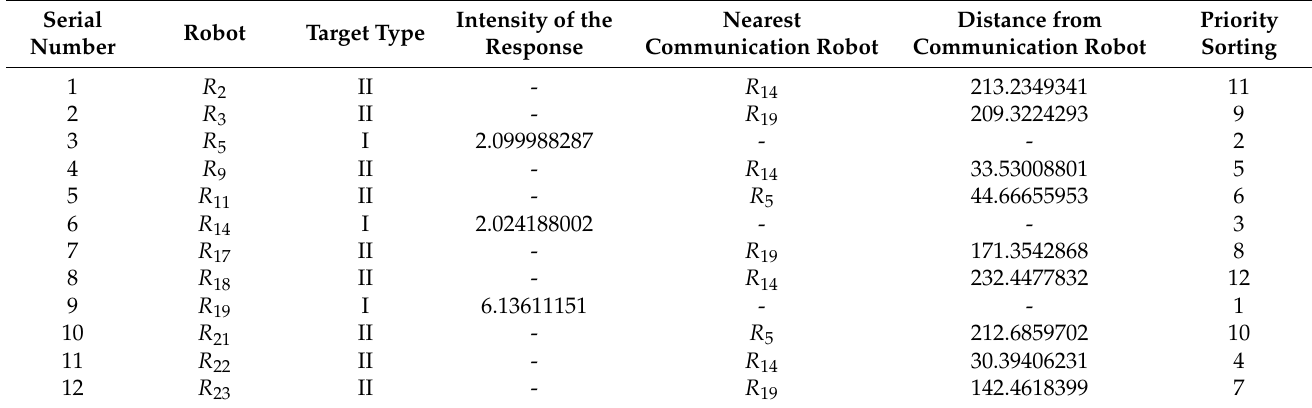
Table 1. Group drones rank the suballiance U 1 members at t =